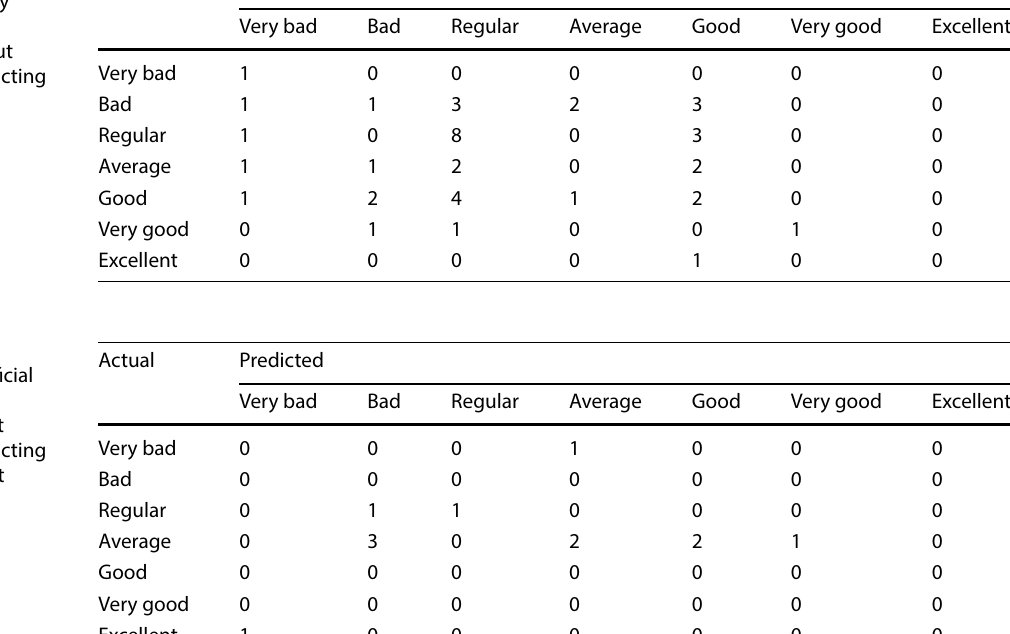
Table 4 Classification confusion matrix via fuzzy logic approach using categorical values as input data for categorical predicting